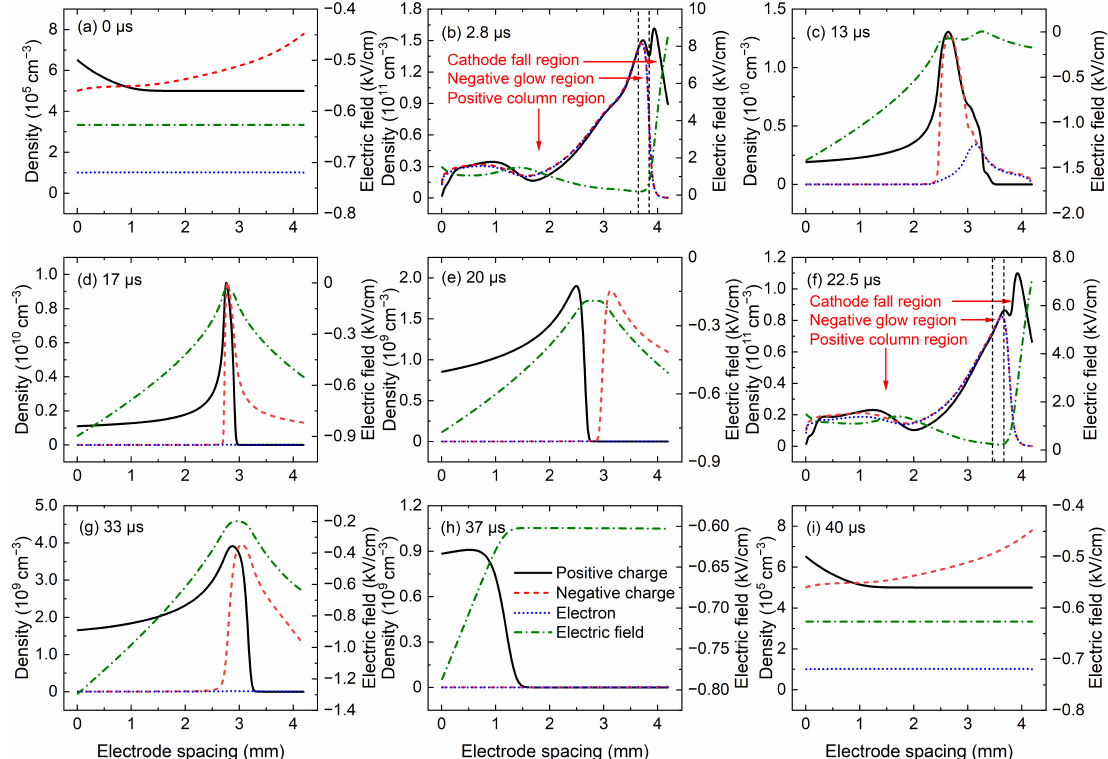
Figure 7. Spatial distributions of positive charge density, negative charge density, electron density, and electric field at several key moments in P2